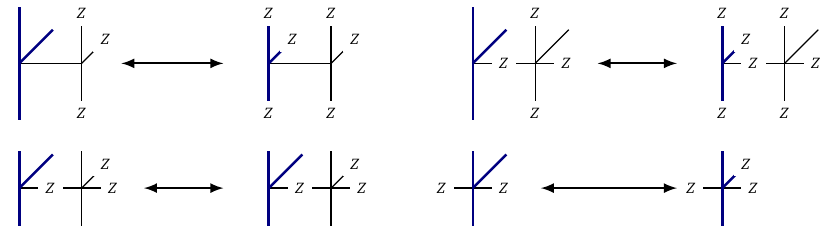
Figure 12: Adjoint action of the circuit on the stabilizers of the two systems in the case of a smooth boundary. Bold (blue) lines correspond to edges of the new leaf. The plaquette / cube terms transform exactly like the case without